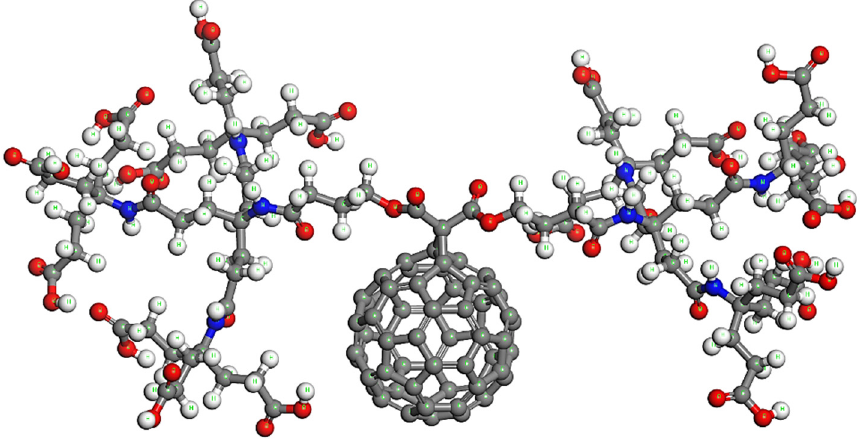
Figure 3. The optimized molecular structure of the dendro[60]fullerene.